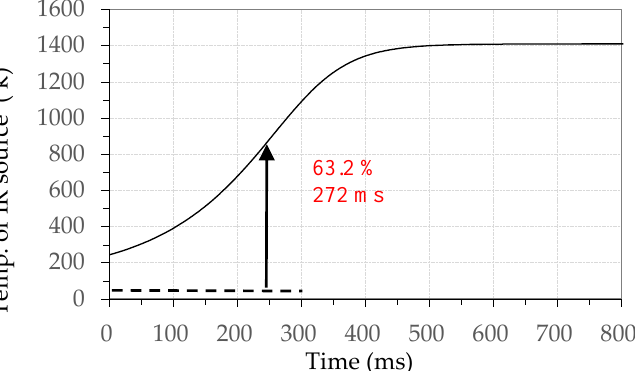
Figure 8. The rising of temperature of IR light source during heating.